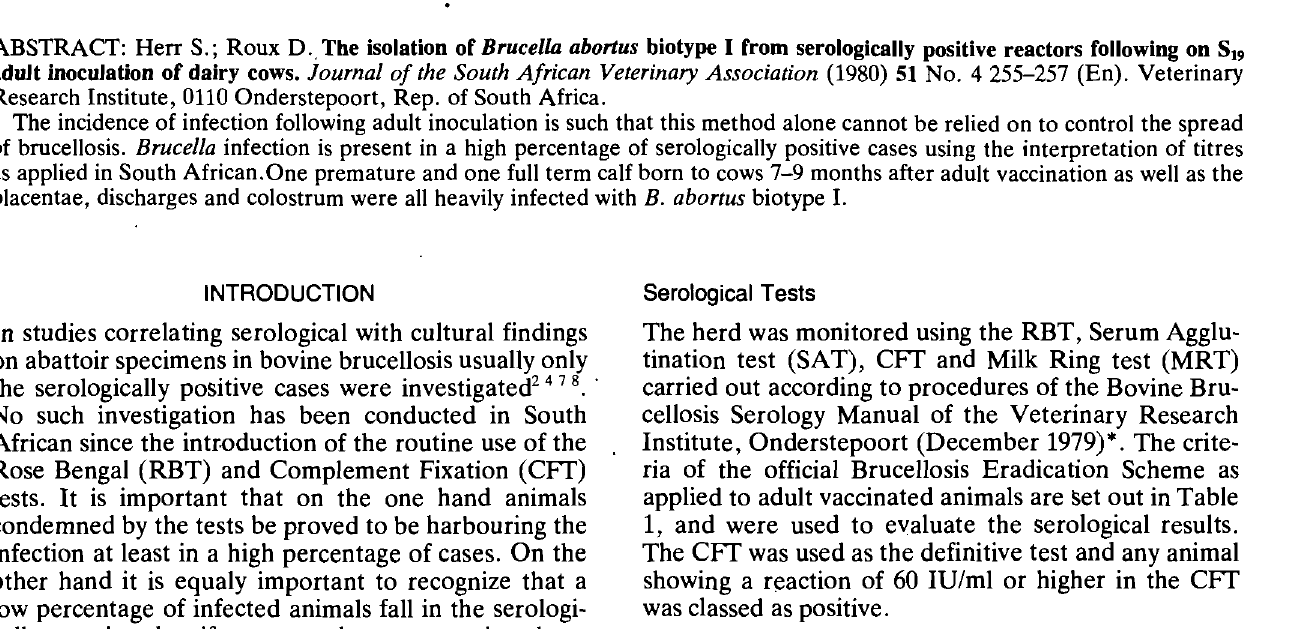
Table 1: INTERPRETATION OF